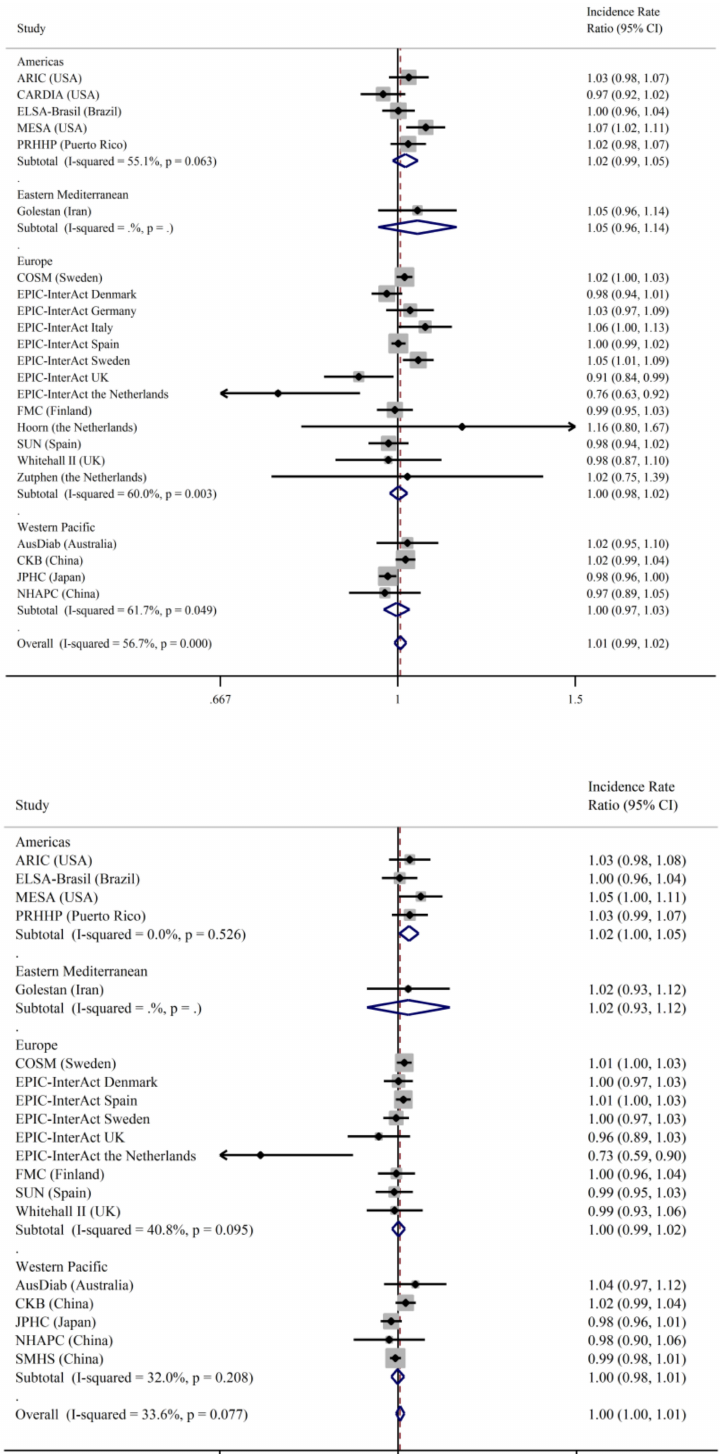
Figure 1. Incidence rate ratios and 95% confidence intervals for the association between the con- sumption of total fish (per 100 g/day) and incident type 2 diabetes (primary outcome) in men in the InterConnect project. Model 1 (upper panel) adjusted for age, education, smoking, physical activity, alcohol intake, BMI, and comorbidities at baseline. Model 2 (lower panel) was additionally adjusted for dietary factors: energy intake, intake of fibre, red and processed meat, fruit,